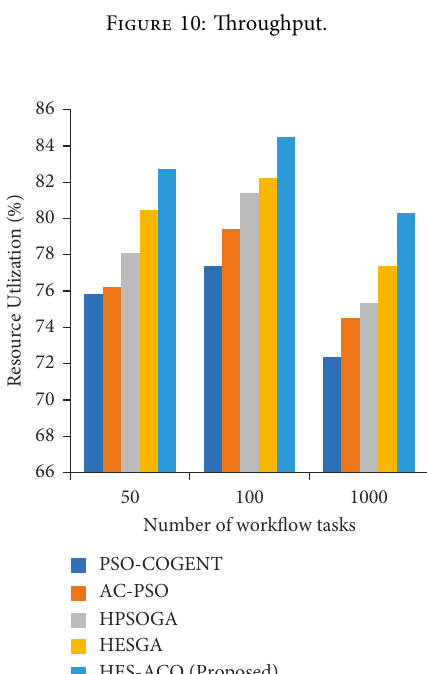
Figure 10: Throughput.